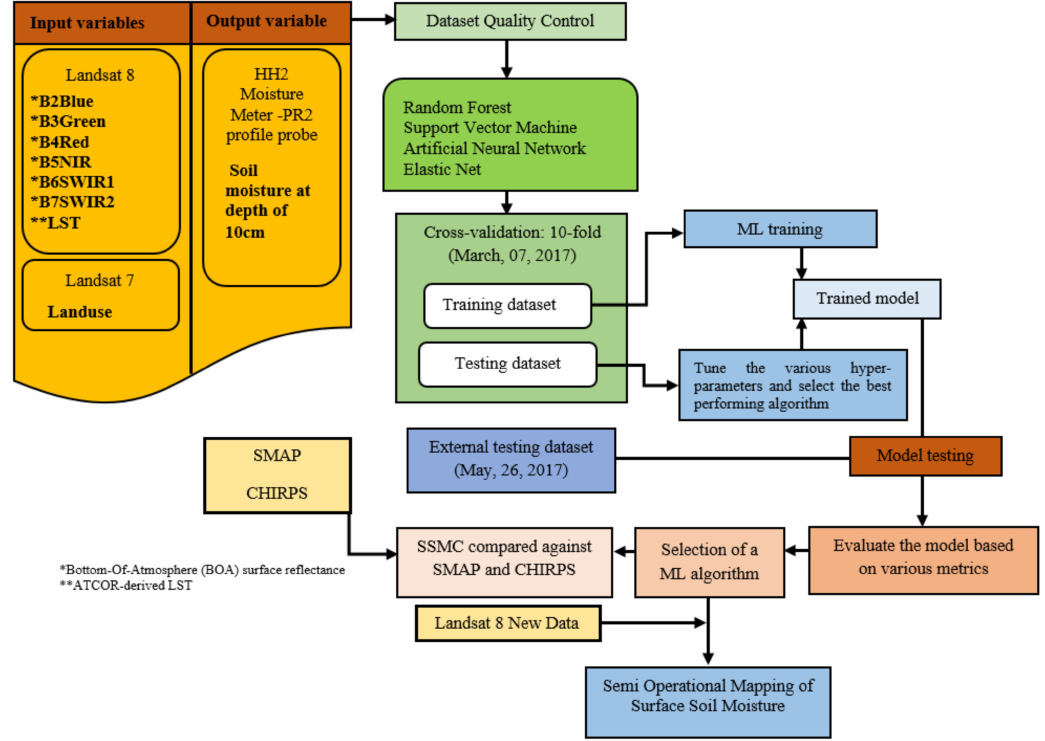
Figure 3. Flowchart of the proposed SMC retrieval